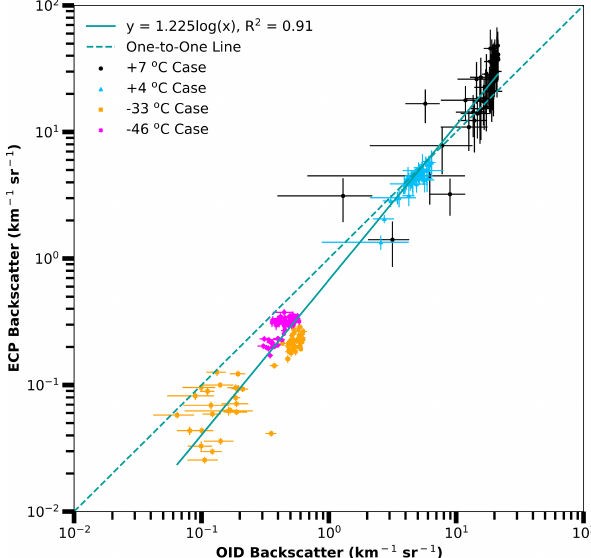
Figure 8. The Optical Ice Detector (OID) versus external cloud probes (ECP) backscatter coefficients for four analyzed cases (Ta- ble 2). Each point is colored by case (see legend) and represents 1s of data (Fig. 5), with bars indicating uncertainty. The least square fit is given by the solid line (see equation in legend). The dashed line is a one-to-one correspondence for the ECP and OID data. The ECP backscatter coefficient is obtained using image data processed with the area-equivalent method for all